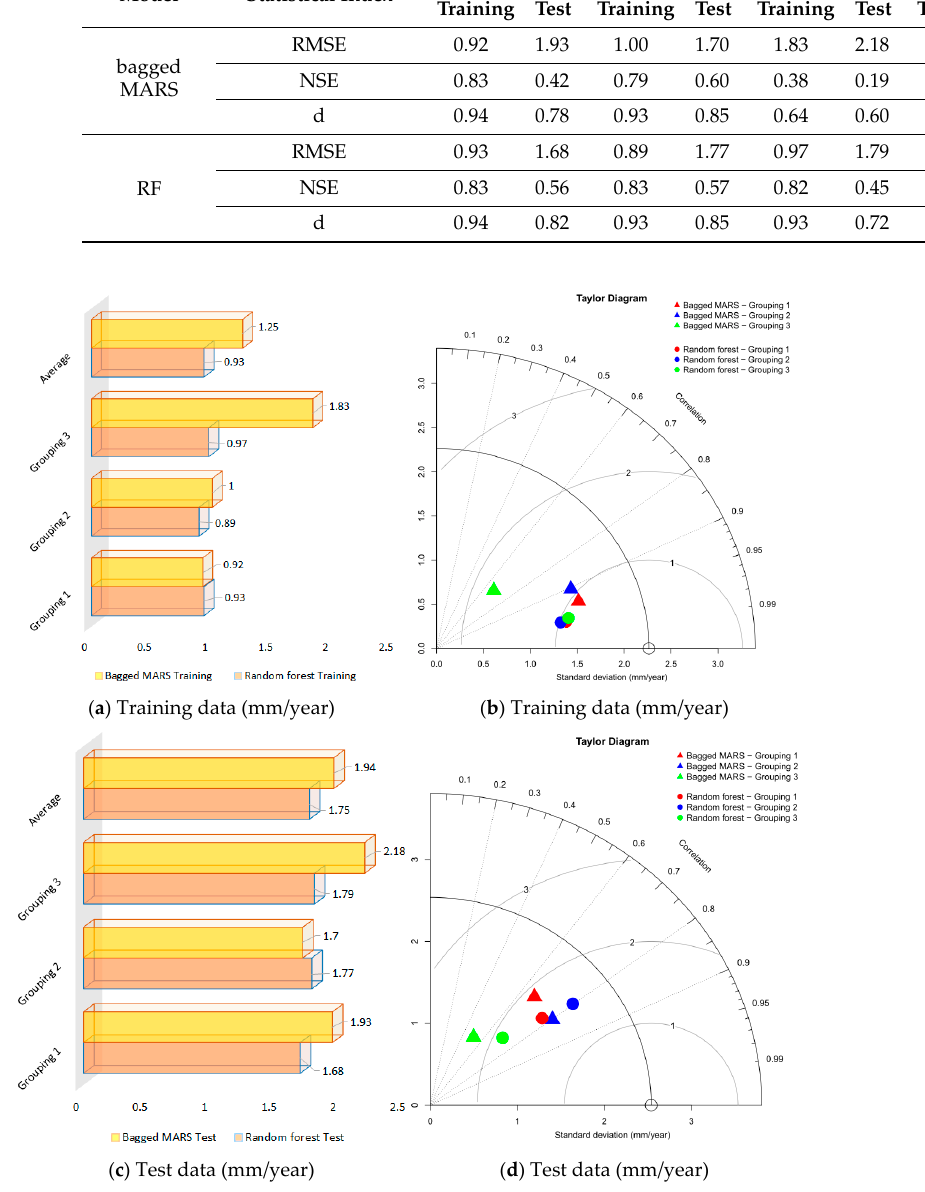
Figure 4. The comparison of RMSE (mm/year), standard deviation, and correlation between bagged MARS and random forest.